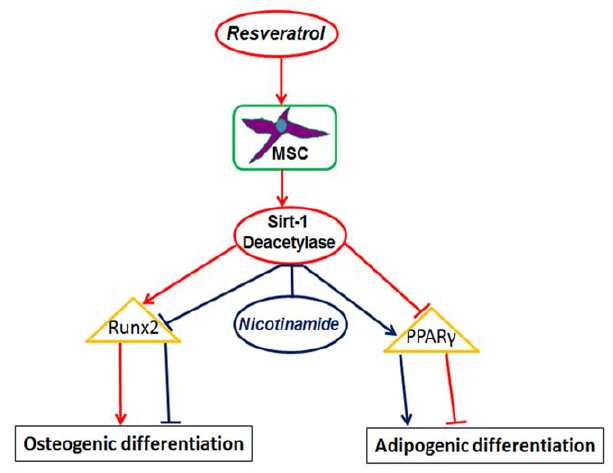
Figure 9. The cell signaling pathway for osteogenic/adipogenic differentiation in MSCs by resveratrol.